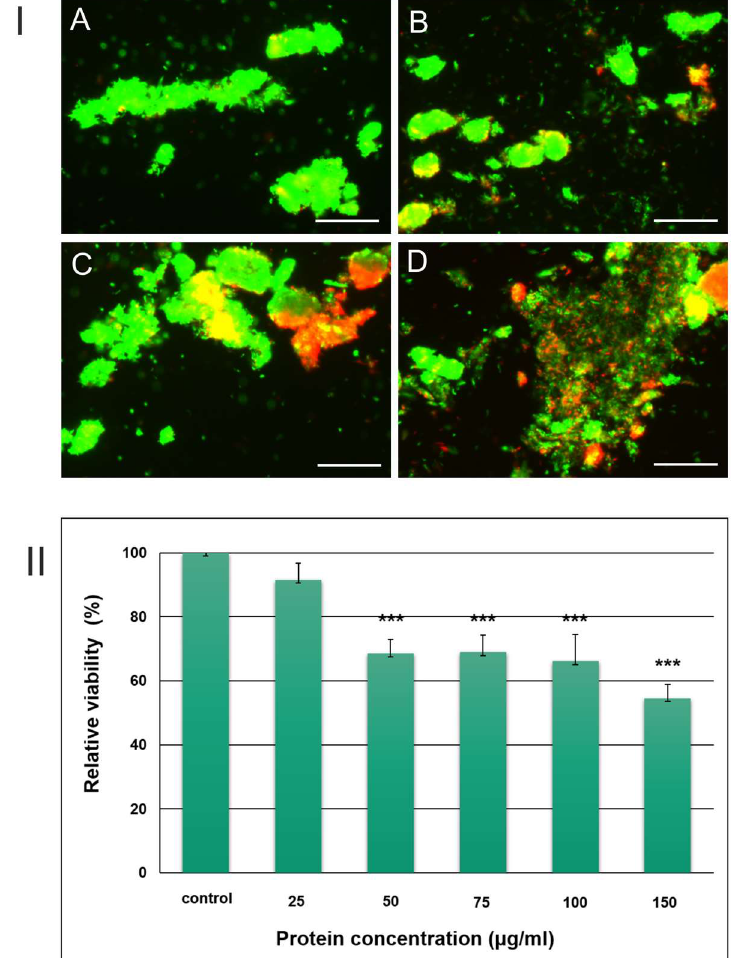
Figure 4. Viability of M. smegmatis cells in the control culture and cells incubated with the protein seed extract (PSE) for 6 days at 37 °C. ( I ). Visualization of M. smagmatis after PSE-treatment with LIVE/DEAD BacLight Bacterial Viability Kit: A—control culture , B—cells after treatment with PSE at the protein concentration of 25 µg/mL C—with PSE at 75 µg/mL; D—with PSE at 150 µg/mL. The scale bar corresponds to 50 µm. ( II ). Relative viability of M . smegmatis after treatment with PSE at different concentrations. The data are expressed as the mean with standard deviation (±SD) from three independent experiments. Statistical significance (compared to the control): *** p ≤ 0,001.